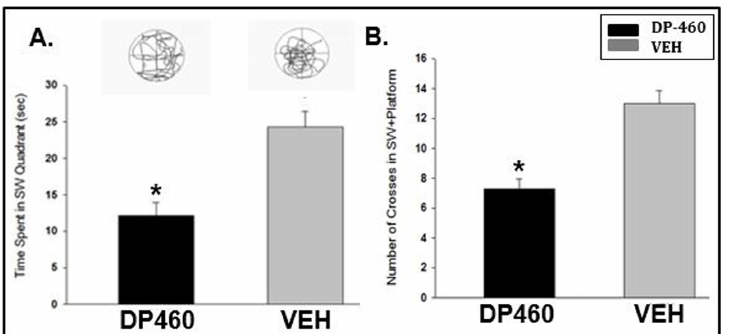
Fig 3. DP-460 impairs learning and memory in the Morris water maze. A significant decrease in time spent in seconds for the DP-460 group (A) and the number of crosses (B) in the Southwest (SW) quadrant during the probe trial ( � p < 0.001), indicates poorer performance for the drug-treated animals. Corresponding trace diagrams reveal the swimming path of the rat to the goal quadrant.